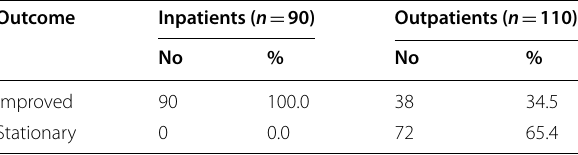
Table 6 Distribution of the two studied groups according to treatment outcome Outcome